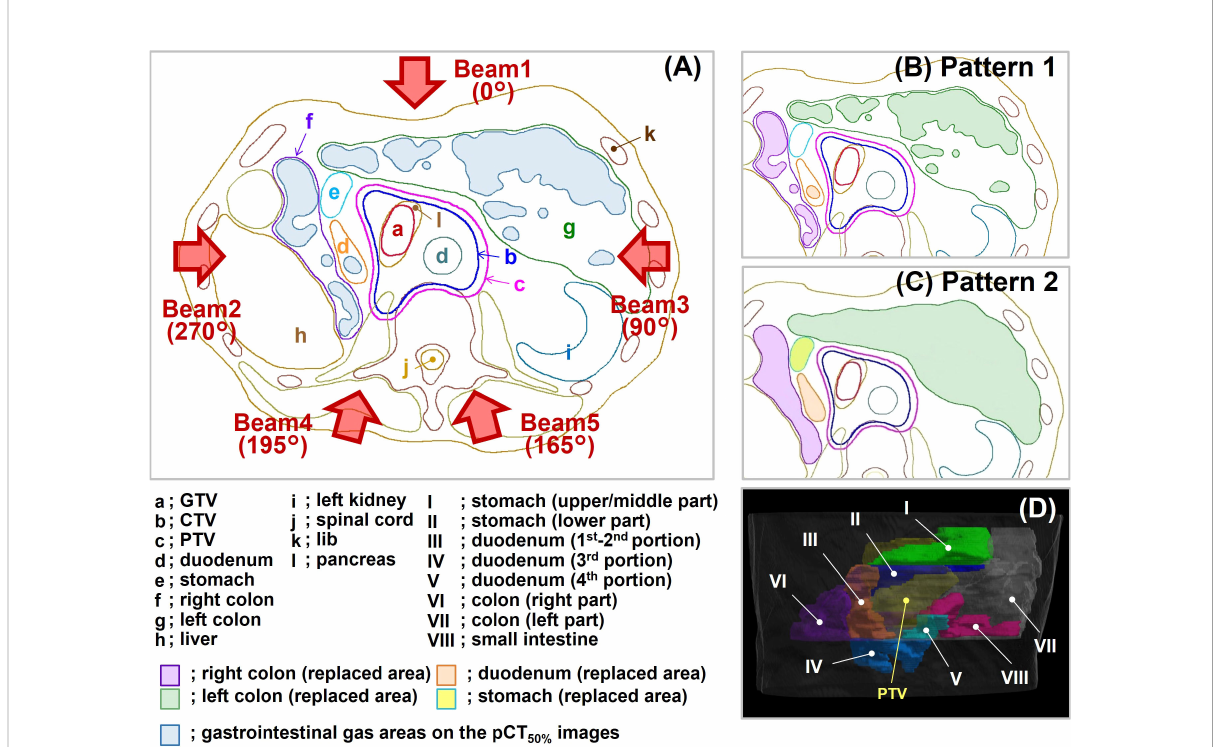
FIGURE 2 Replacement patterns and beam direction. (A) The supine position without replacement. This condition corresponds to Pattern 3. The blue- fi lled areas in the illustration represent gastrointestinal gas (G-gas). The gantry angle is indicated by a brown arrow. (B) The replacement condition in Pattern 1. (C) The replacement condition in Pattern 2. (D) Eight replacement regions in Pattern 2. GTV, gross tumor volume; CTV, clinical target volume; PTV, planning target volume; pCT 50% images, planning CT images of the maximum exhalation